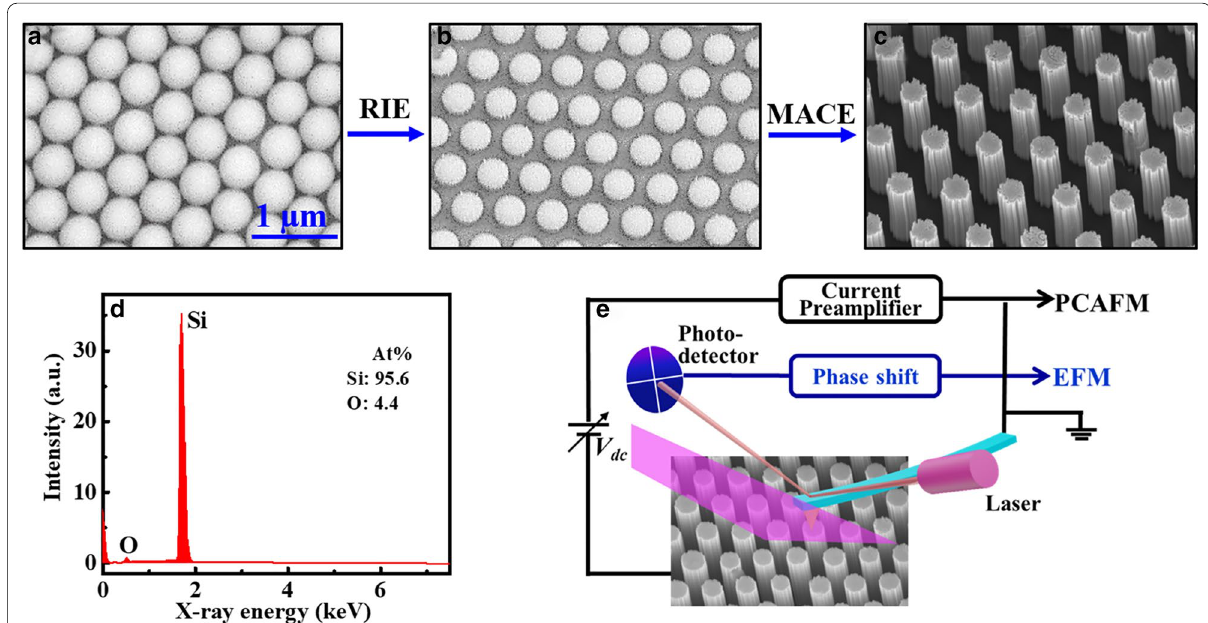
Fig. 1 a – c SEM images of main procedures to fabricate vertically aligned Si NWs array: a Self-assembled PS monolayer, b diameter-reduced PS monolayer and c fabricated Si NWs array. d EDX spectrum measured on Si NWs. e Schematic diagrams of PCAFM and EFM under laser